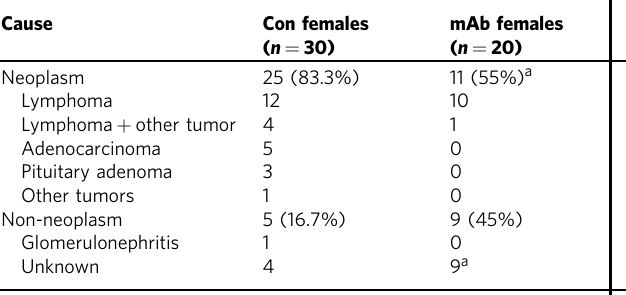
a Signi fi cantly different from Controls by chi-square test or Fisher ’ s exact test, respectively, P ≤